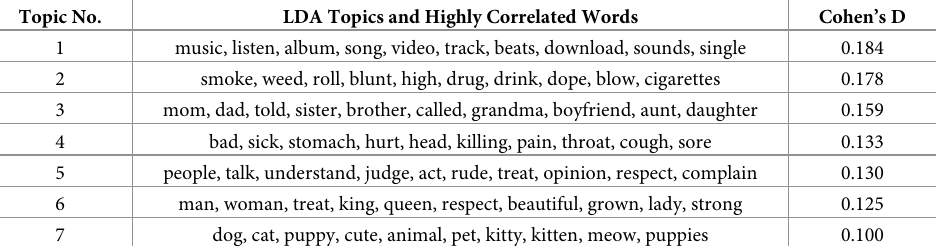
Table 3. Results from LDA analysis for users who express loneliness on Twitter and are between the ages of 30 and 65. Topic No.